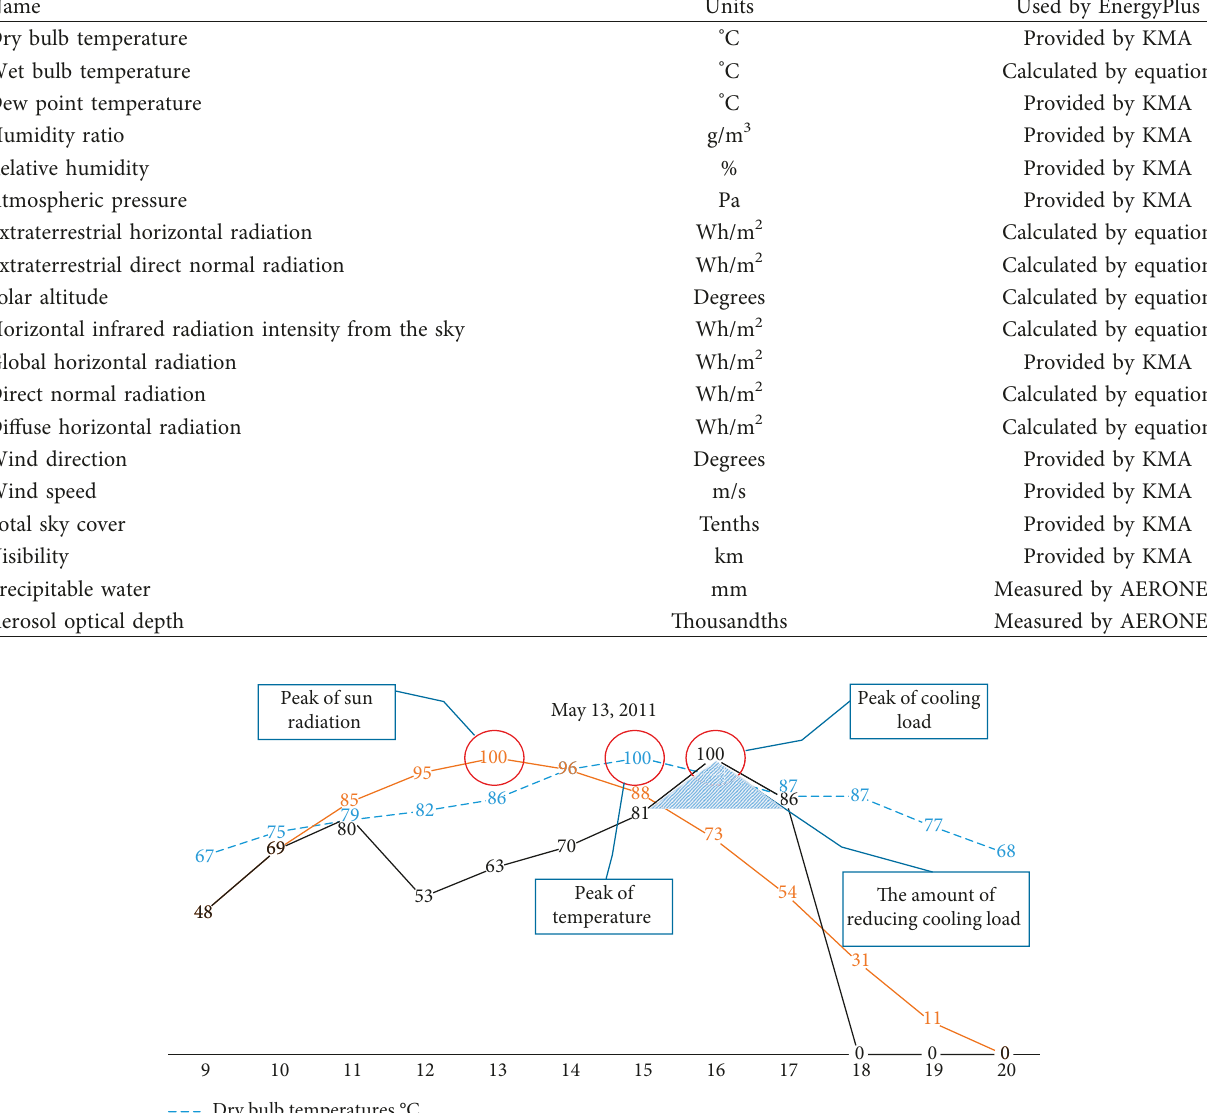
Table 1: Weather data and aerosol data considered in this study.